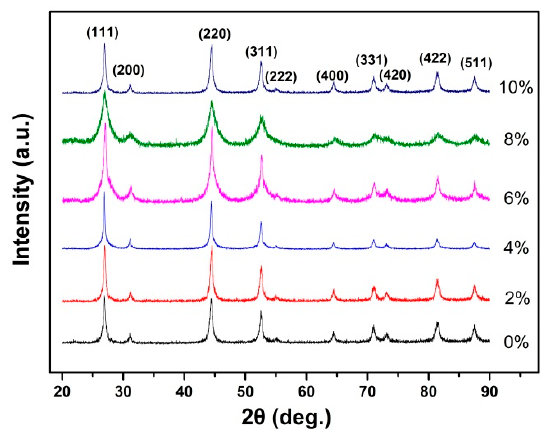
ff erent Tb doping